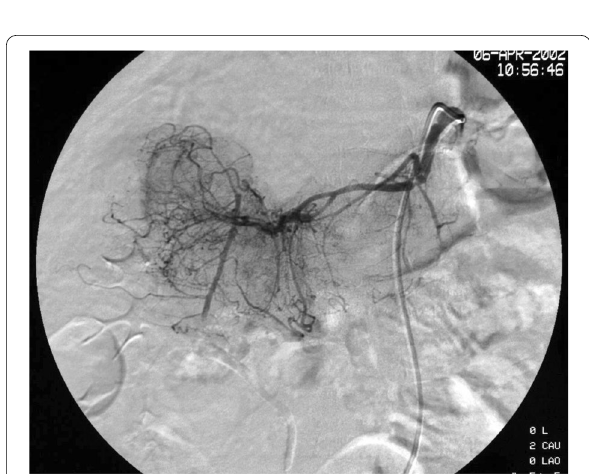
Fig. 4 Angiograms showing a hyper‑vascular tumor fed by the right branch of the middle colic